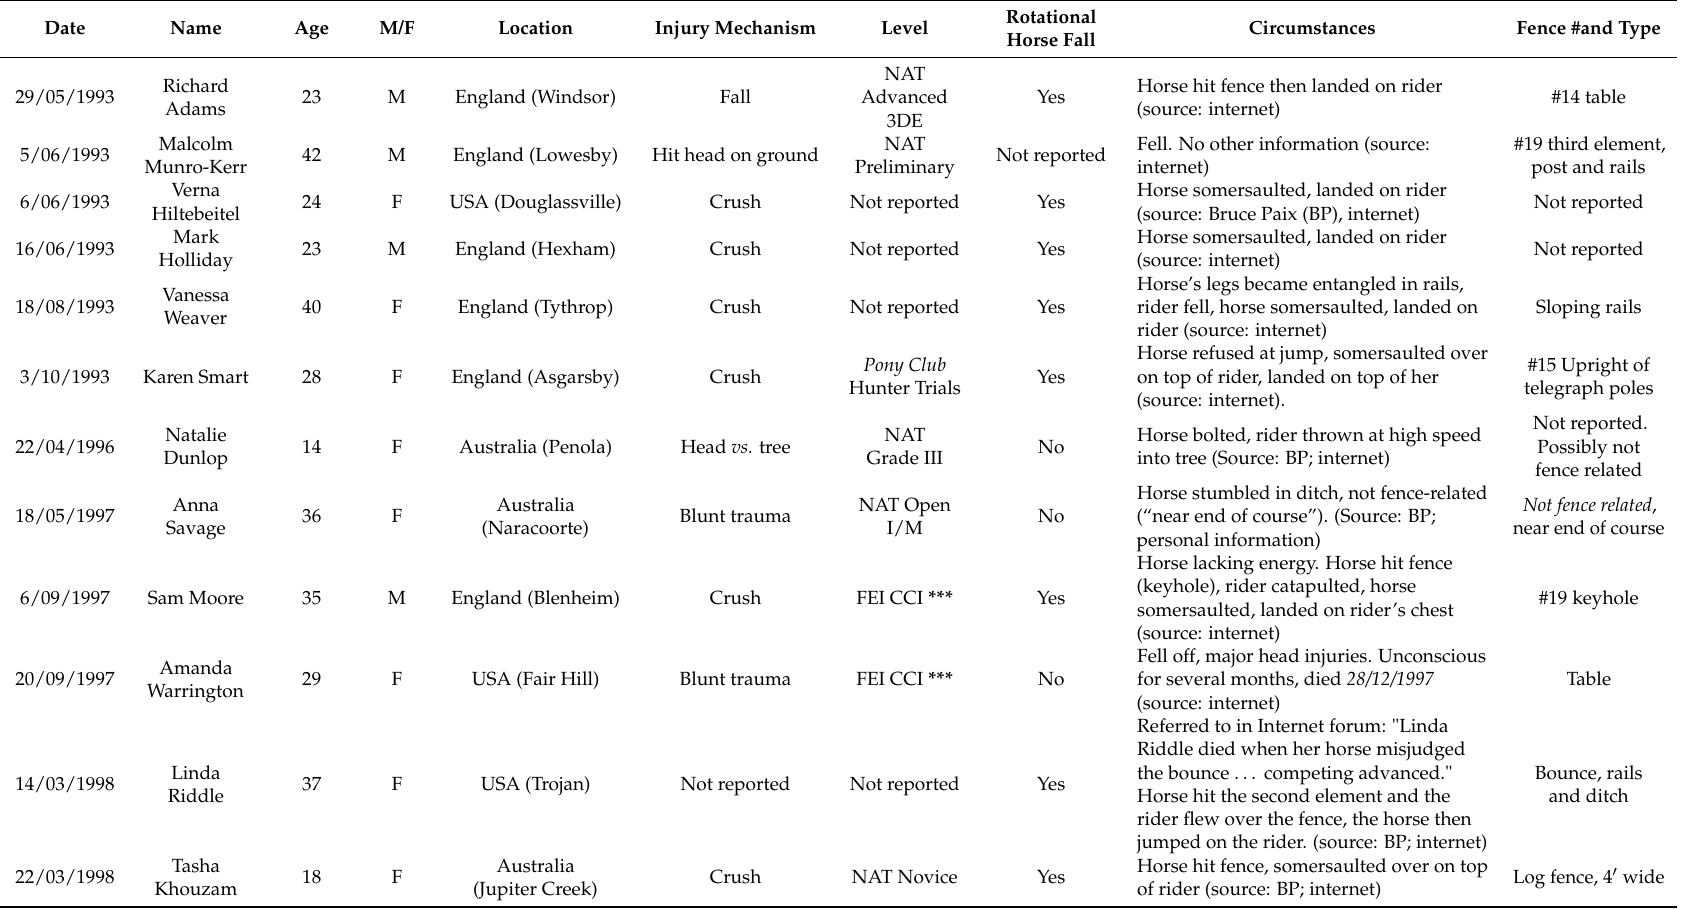
Table A1. Fatalities in eventing,